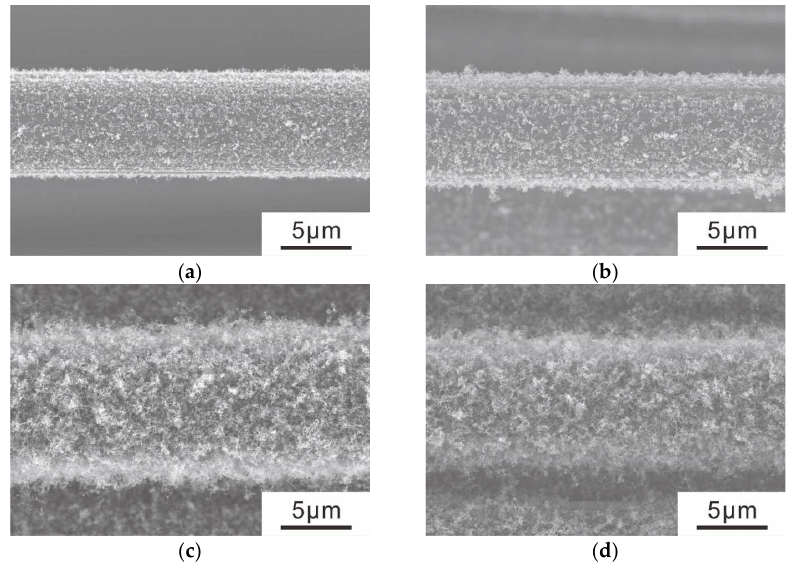
Figure 14. Schematic drawings of diffusion distance of cations in ( a ) sufficiently longer OFF-time and ( b ) shorter OFF-time.